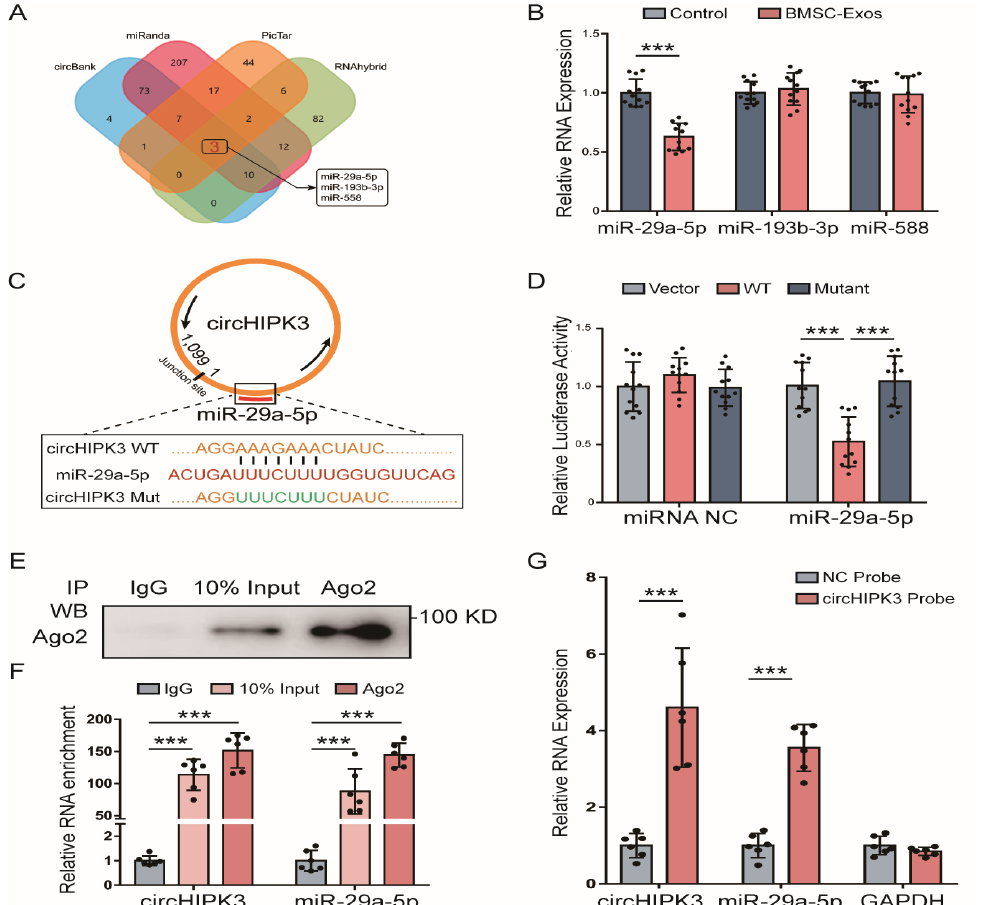
Figure 4. CircHIPK3 served as a miRNA sponge of miR ‐ 29a ‐ 5p. ( A ) Three miRNAs (miR ‐ 29a ‐ 5p, miR ‐ 193b ‐ 3p and miR ‐ 558) were predicted to be candidate targets of circHIPK3. ( B ) Expressions of miR ‐ 29a ‐ 5p, miR ‐ 193b ‐ 3p and miR ‐ 558 in MC3T3 ‐ E1 cells treated with BMSC ‐ Exos ( n = 12). ( C ) Schematic representation of circHIPK3 with the predicted target site for miR ‐ 29a ‐ 5p. The mutant site of circHIPK3 is indicated (green). ( D ) Luciferase reporter analysis was performed to examine the binding ability between miR ‐ 29a ‐ 5p and circHIPK3. Reporter constructs containing either circHIPK3 ‐ WT or circHIPK3 ‐ Mut at the predicted miR ‐ 29a ‐ 5p target sequences were co ‐ transfected into HEK293T cells, along with miR ‐ 29a ‐ 5p or miRNA NC mimics ( n = 12). ( E , F ) RIP experiments were performed using the Ago2 antibody (E) and specific primers were used to detect the enrich ‐ ment of circHIPK3 and miR ‐ 29a ‐ 5p in MC3T3 ‐ E1 (( F ), n = 6). *** p < 0.001. ( G ) Biotinylated ‐ probe pull ‐ down assay for circHIPK3 and miR ‐ 29a ‐ 5p by qRT ‐ PCR in MC3T3 ‐ E1 cells ( n = 6). The probe was designed according to the junction region of circHIPK3. *** p < 0.001.